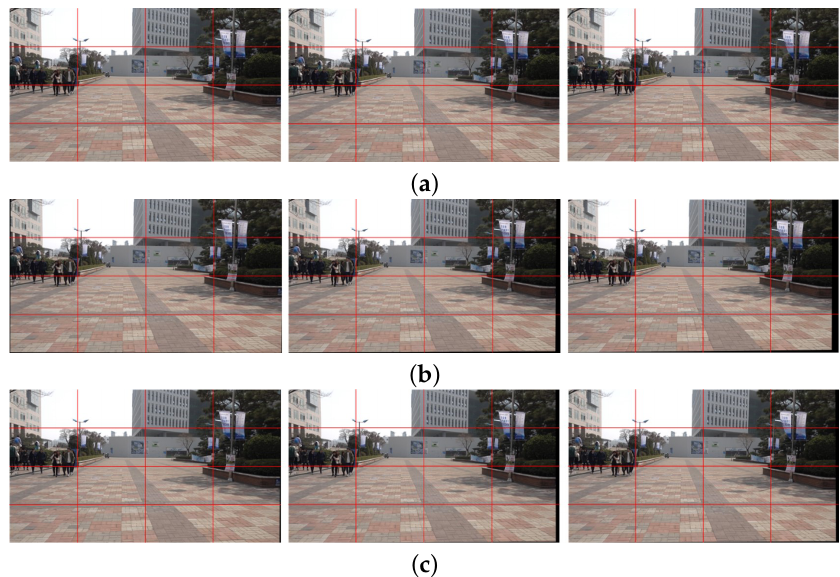
Figure 13. Experimental results of various camera path smoothing methods: ( a ) the input shaky video frames (275th, 276th, and 277th frames), ( b ) the stabilized video using a moving average filter [7], and ( c ) the proposed video stabilization method.